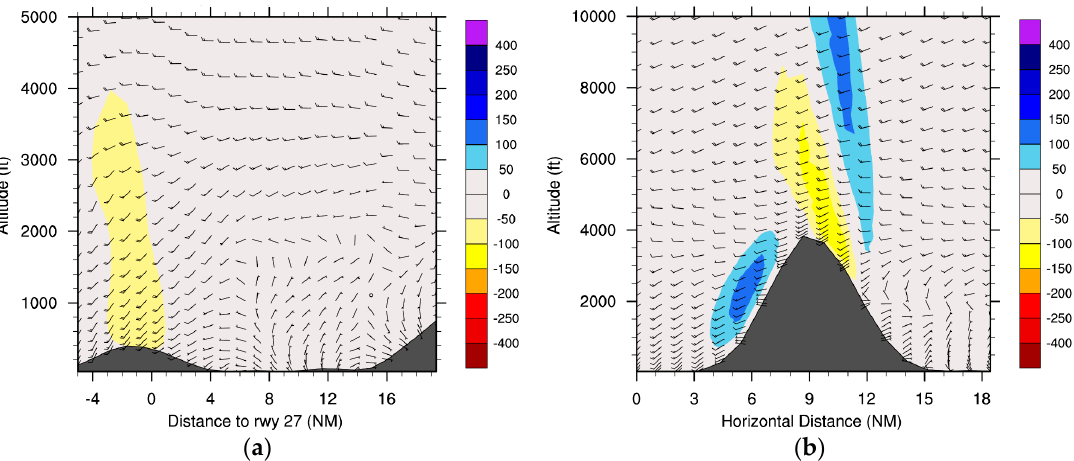
( b ) Figure 12. ( a ) Horizontal wind at 135 ft (40 m) for Flight 2.; ( b ) Maximum vertical velocity component under 6000 ft (1829 m) for Flight 2. Both fields are from AROME forecasts. Shading in ( a ) represents the wind speed in kt and the pink dot identifies the approximate aircraft position at this level. Pink dashed line identifies the approximate aircraft trajectory. Shading in ( b ) represents intensity in ft/min, positive values indicate upward vertical velocity and negative values represent downward vertical velocity. The pink dots are the points C and D shown in Figure 2, which are the endpoints of cross-section (dashed pink line) used in the next figures.